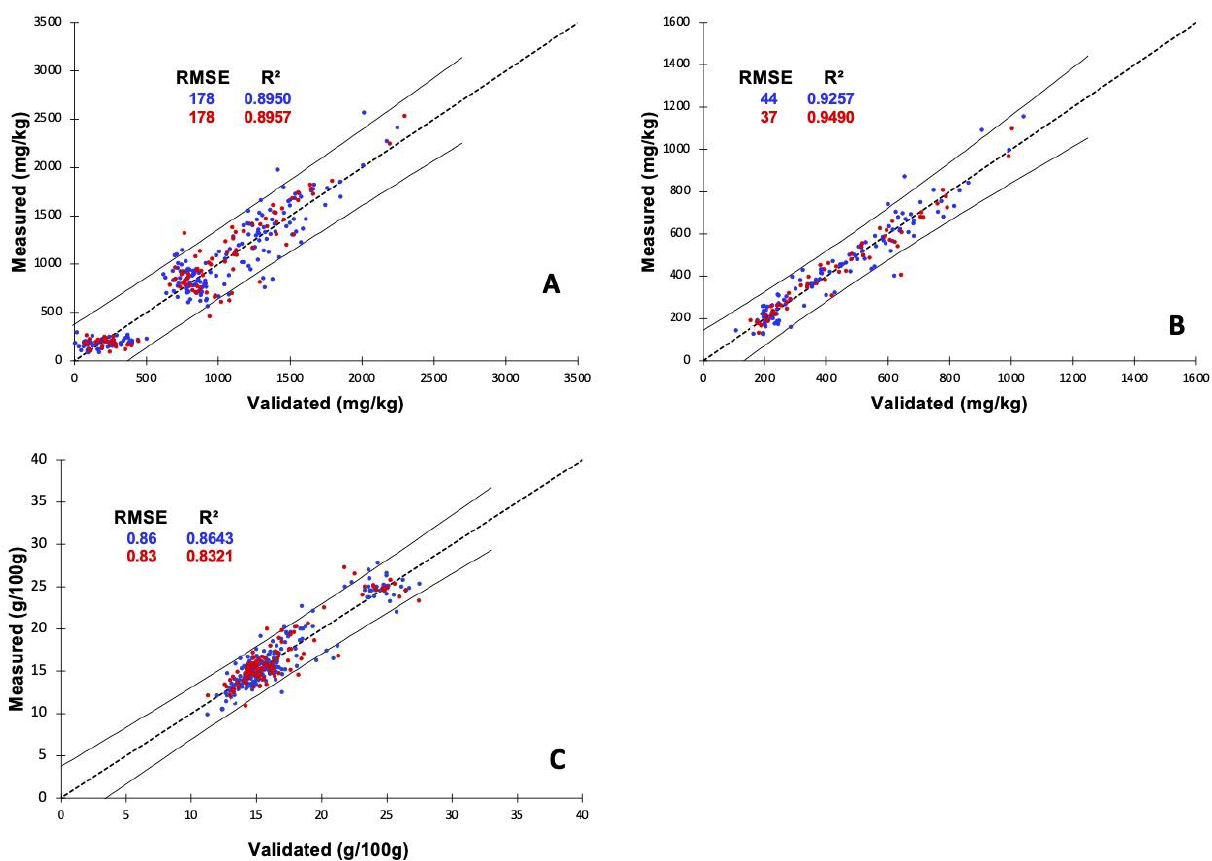
Figure 7. Performance of MLR model using the optimal wavelengths extracted from VIPs score of the best full-spectrum PLS analysis. Calibration and external validation from SNV pre-treated data for ( A ) Total Flavonoids, ( B ) Total Anthocyanins, and ( C ) Total Soluble Solids. Blue dots indicate calibration set and red dots represent validation set.